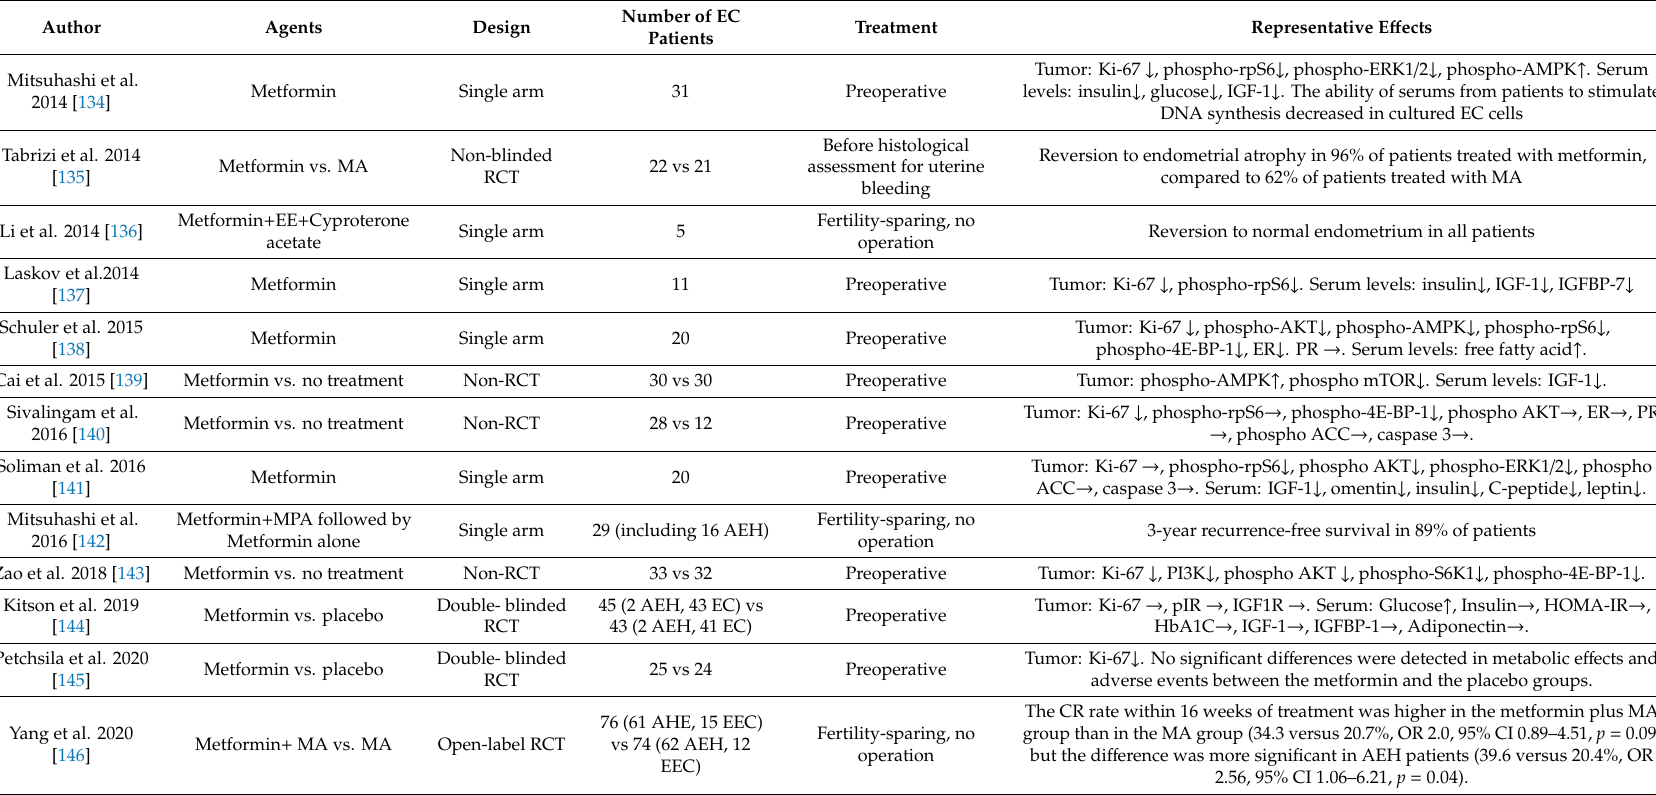
Table 1. Representative clinical trials for endometrial cancer using